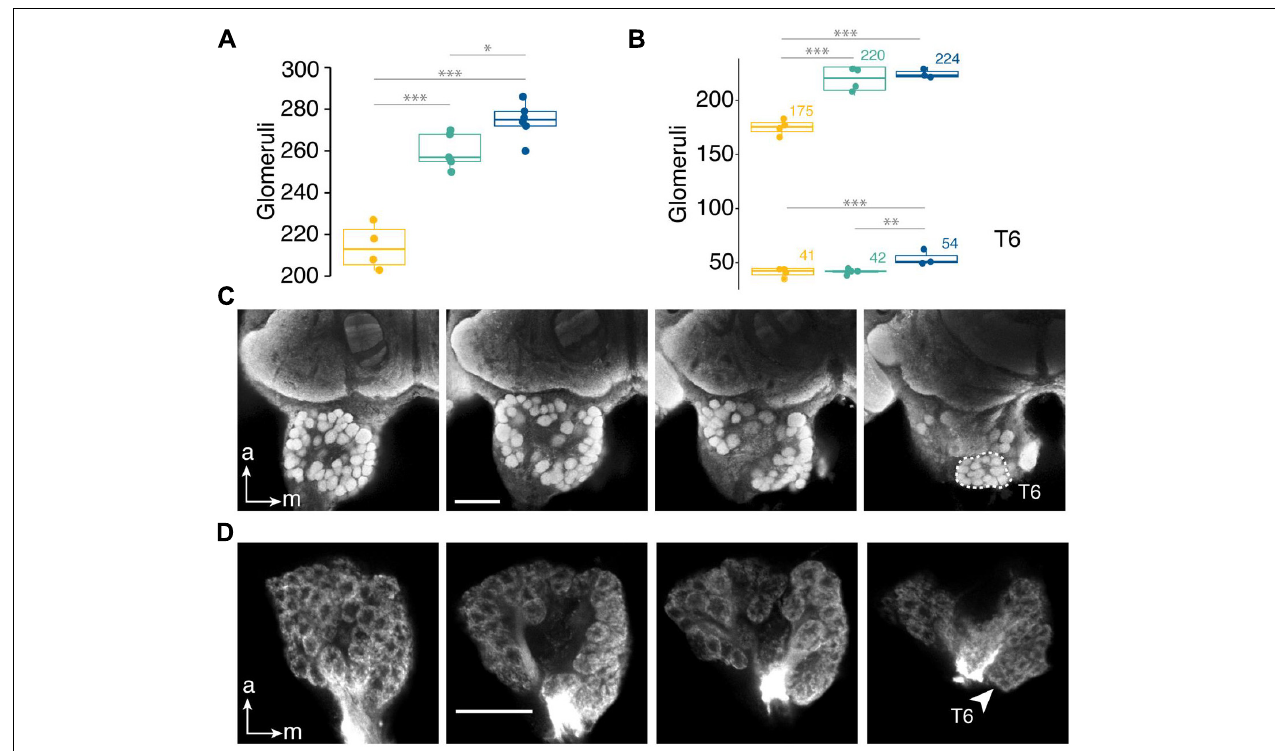
FIGURE 4 | Glomeruli in the T6 cluster account for differences in antennal lobe glomeruli between Dorymyrmex species. (A) Number of antennal lobe glomeruli. (B) glomeruli in the T6 cluster and other clusters in three species that vary in colony size. Number above boxes indicate mean glomeruli number for T6 cluster (bottom) and all other glomeruli (top). Species ranked in order of increasing mean head width along the x-axis. (C) Synapsin-labeled antennal lobe and (D) mass staining (dextran tracer) of antennal sensory neurons in the antennal lobe of D. bicolor with T6 cluster outlined (C) or indicated by arrowhead (D) , scale bars = 50 µ m. Generalized linear model with gamma distribution and log link function used for statistical comparisons. Pairwise comparisons made using Tukey’s honestly significant difference (HSD) test. * p < 0.05; ** p < 0.01; *** p <